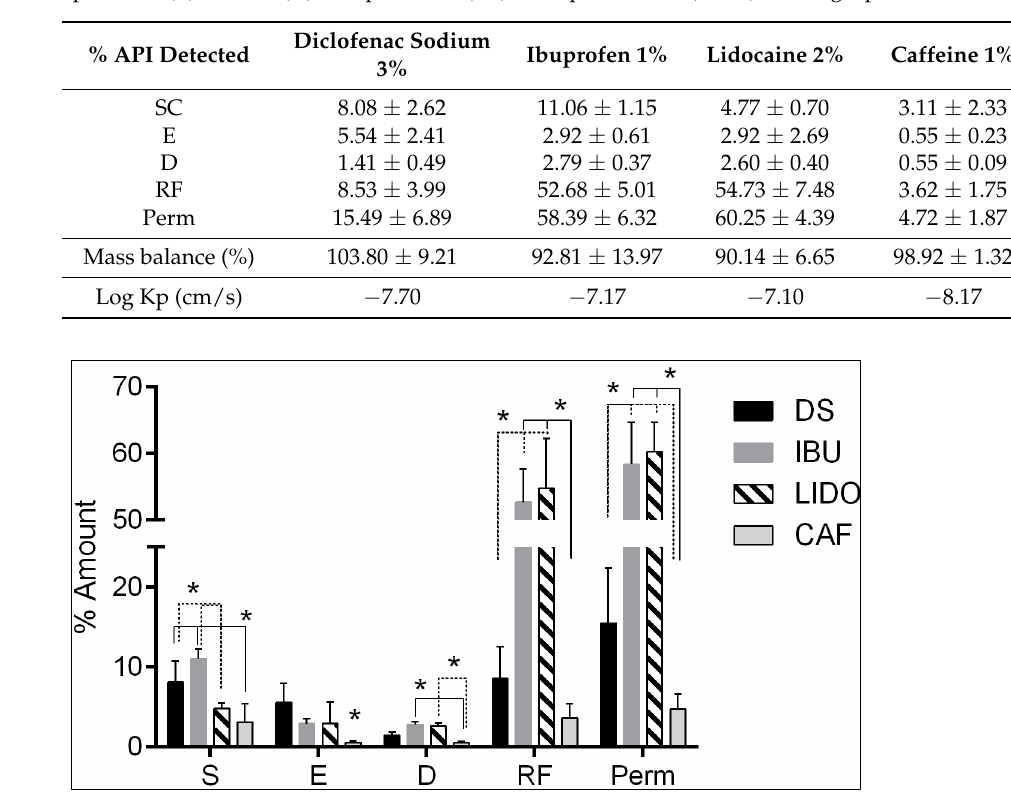
Figure 2. Mean percentages of the amount of diclofenac sodium, ibuprofen, lidocaine, and caffeine applied in finite doses in the different skin strata (stratum corneum (S), epidermis (E), and dermis (D)), receptor fluid (RF), and permeated amount (Perm) (* indicates significantly different, p < 0.05).